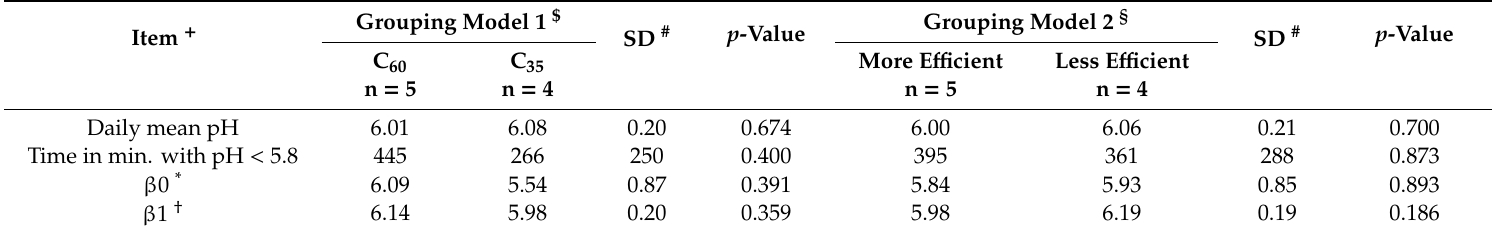
Table 7. E ff ects of concentrate feed proportion in the ration (C) and microbial e ffi ciency (synthesized microbial crude protein / fermented organic matter) on ruminal pH parameters.